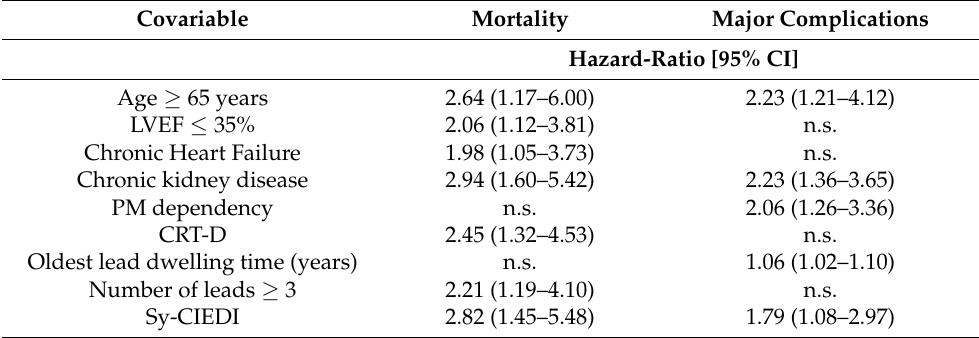
Figure 2. In-hospital procedure-related and non-procedure-related mortality in patients with Sy- CIEDI and Lo-CIEDI (for a detailed description of these cases see [3]). Legend: Lo-CIEDI = local CIED infection; Sy-CIEDI = systemic CIED infection; TLE = transvenous lead extraction. Table 4. Predictors of in-hospital mortality and major complications at univariate cox-regression analysis in a patient undergoing TLE for CIEDI (1850/3555